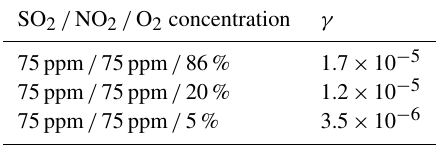
Table 1. Reactive uptake coefficient of SO 2 for sulfate formation at 82% RH and at different O 2